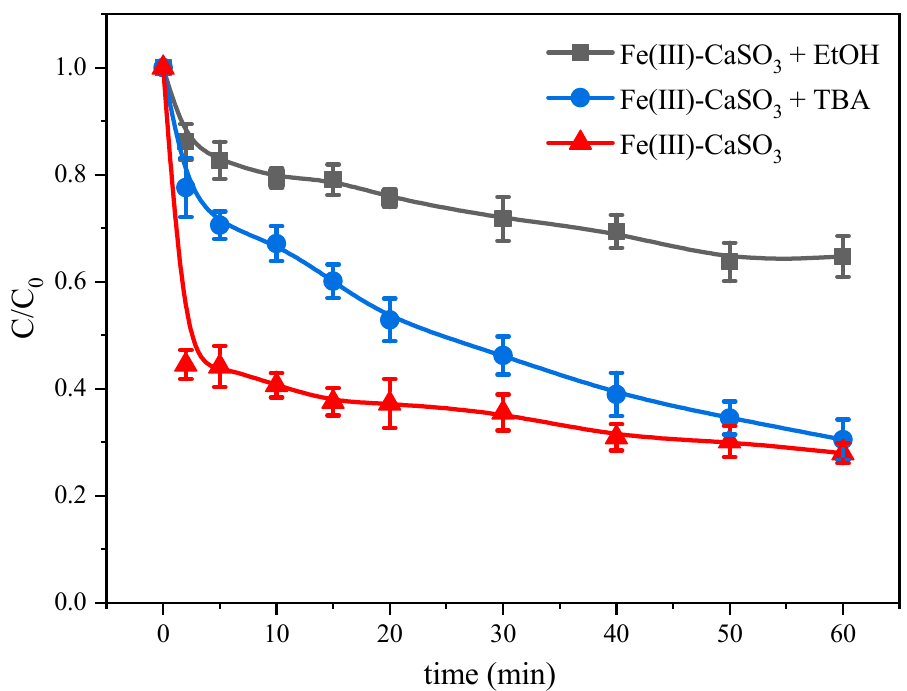
Figure 5. Contribution of free radicals in the Fe(III)-CaSO 3 system. Initial conditions: [Fe(III)] = 0.5 mM, [CaSO 3 ] = 30 mM, [As(III)] = 5 μ M, [EtOH] = 5 mM, [TBA] = 2 mM, pH 6.0, air at 0.5 L min − 1 .